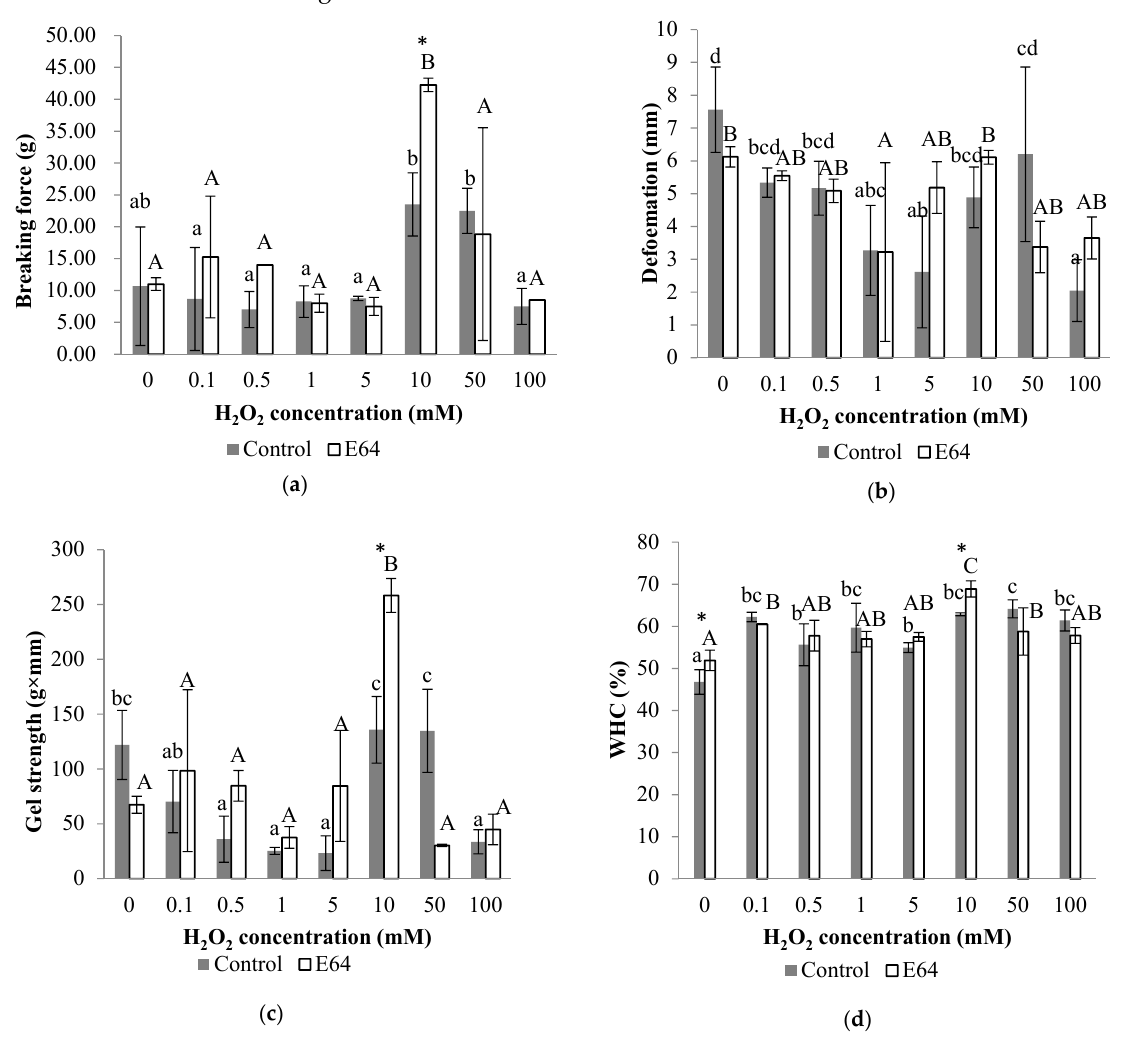
Figure 6. Gel properties of myofibrillar protein gels from bighead carps under different H 2 O 2 concentrations: ( a ) breaking force; ( b ) deformation distance; ( c ) gel strength; ( d ) WHC. The same lowercase letter indicates no significant differences between samples of control group under different H 2 O 2 concentrations. The same capital letter indicates no significant differences between samples of E64 group under different H 2 O 2 concentrations. The asterisk indicates significant difference between samples at control and E64 groups under the same H 2 O 2 concentration ( p < 0.05).